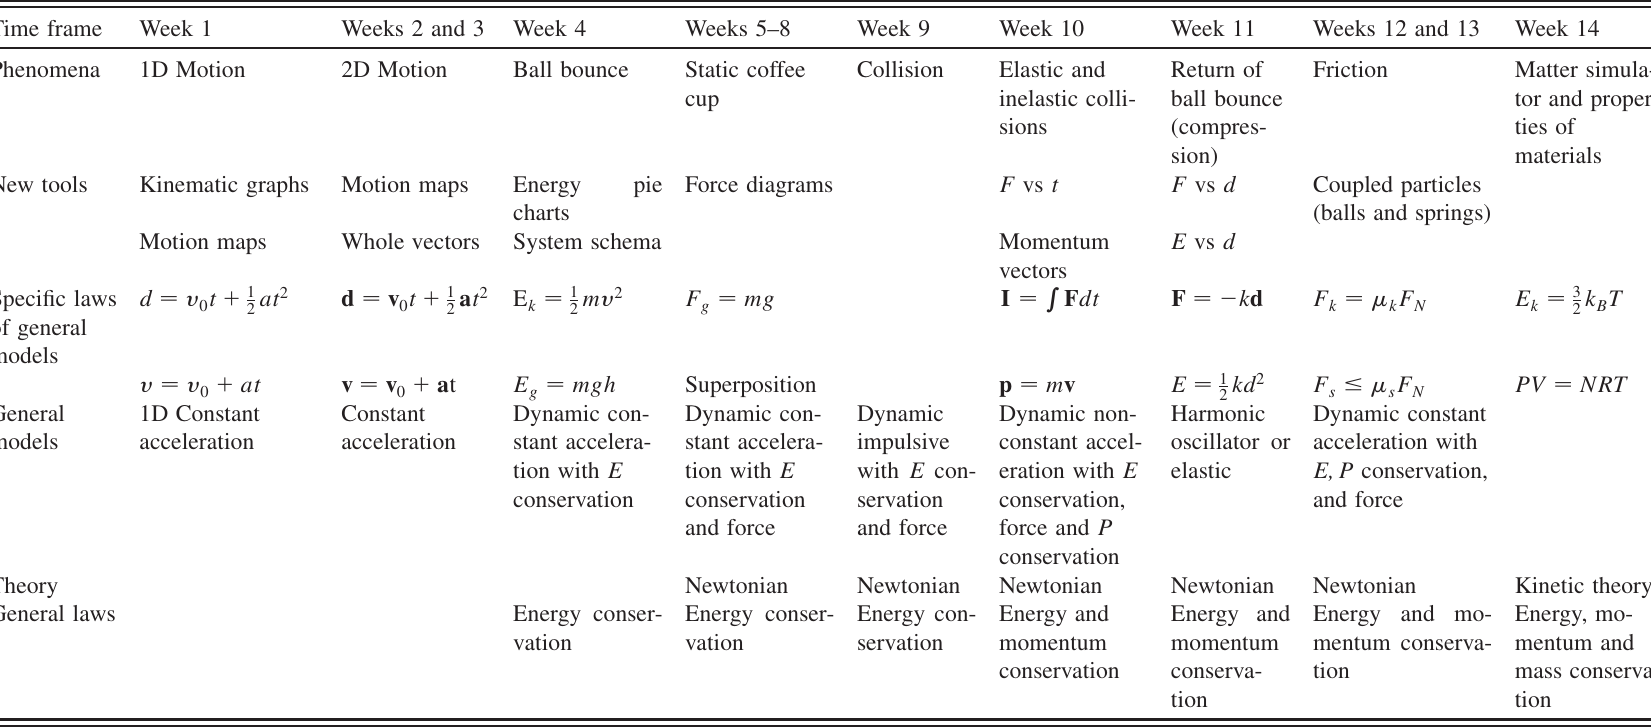
TABLE I. A model-centered introductory mechanics curriculum with a prominent coherent energy framework. Each column represents a cycle of model development, beginning at the top with phenomenology and moving down toward greater abstraction. Instruction progresses from the left toward the right, increasing the sophistication and robustness of the models developed over